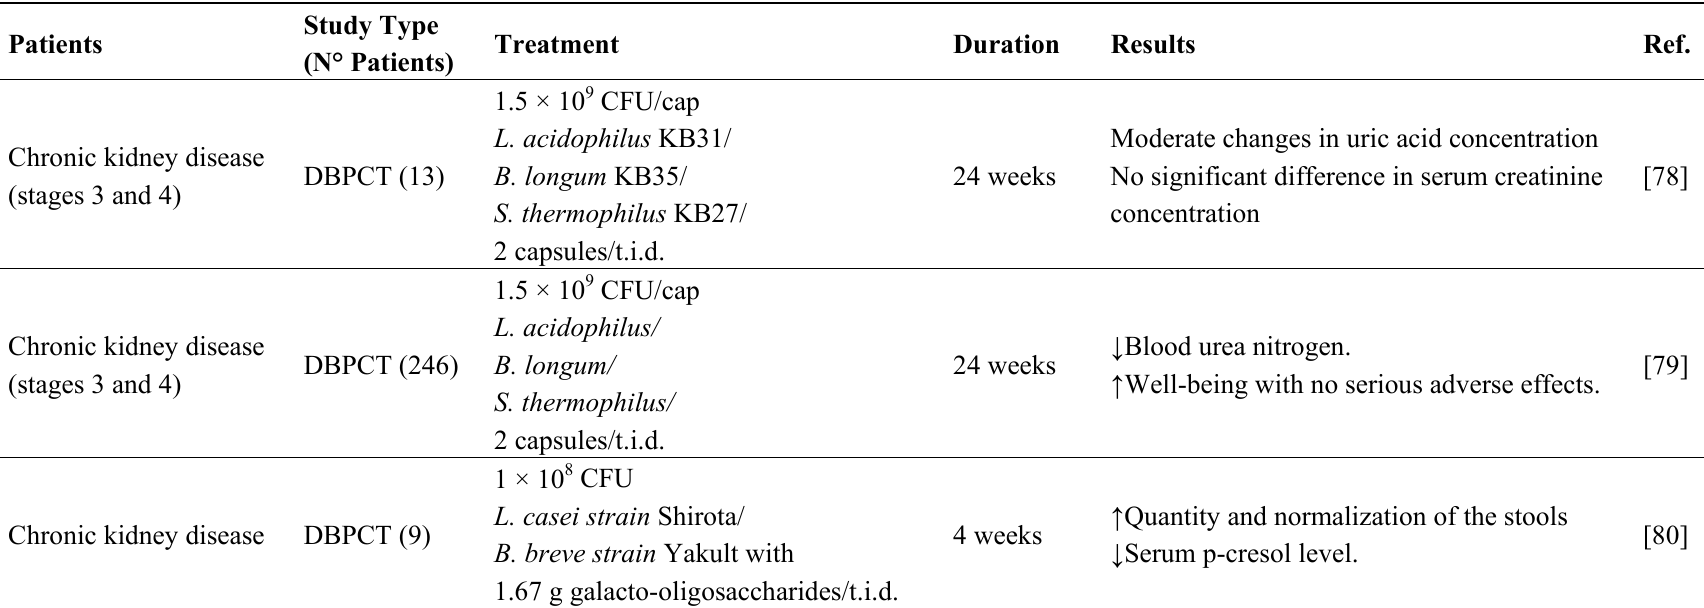
Table 5. Clinical studies of probiotics and chronic kidney